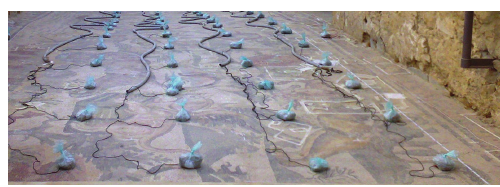
Figure 1: Sandbags on the ECG electrodes (used only for potential measures) on the floor of the Ambulatory of the great hunt at the “Villa del Casale,” Piazza Armerina